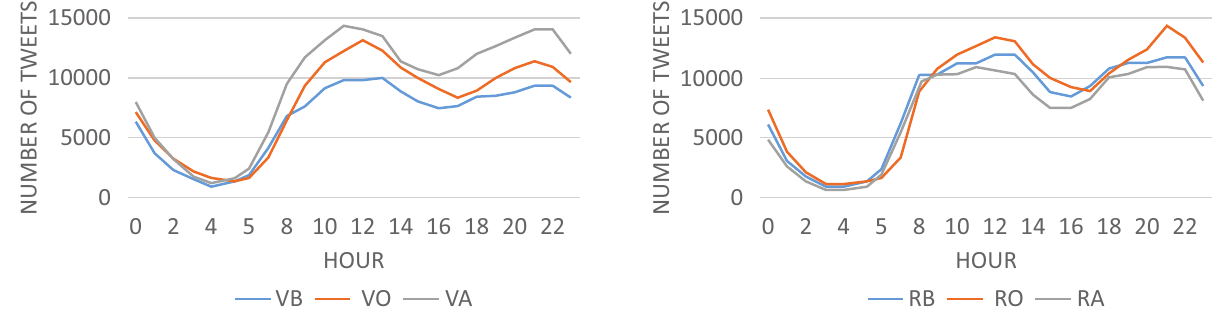
Figure 11. Hourly distribution of the tweets during the three analysis periods (R = residents, V = visitors; B = before OG, O = during OG, A = after OG).